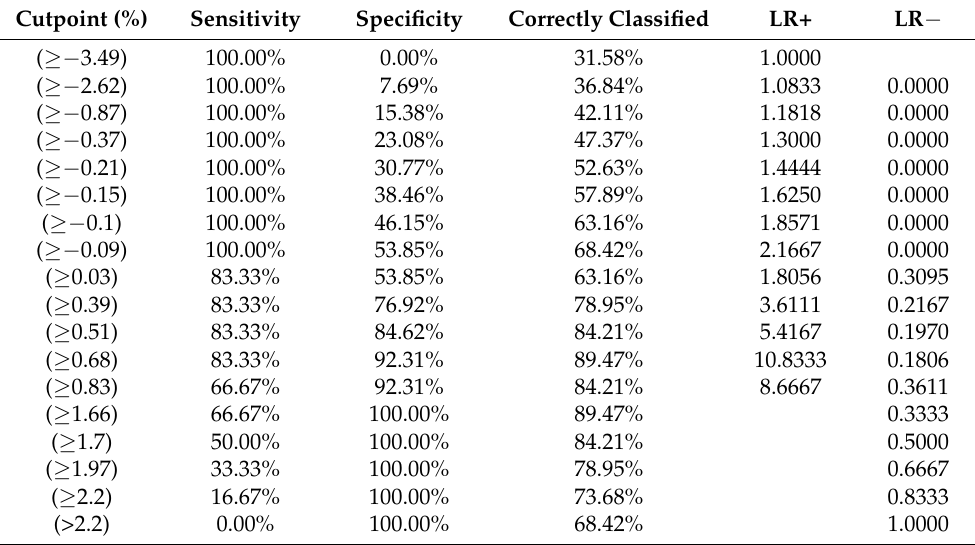
Table A1. Detailed report of sensitivity and specificity: Creatinine change in % within 24 h before and after ECMO